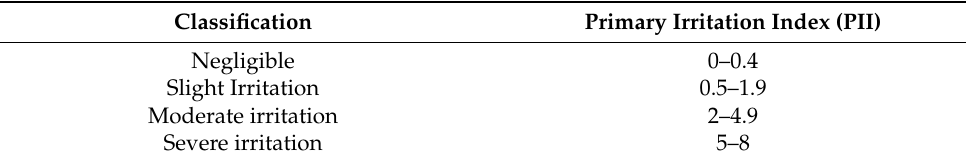
Table 1. Primary Irritation Index (PII) and classification of skin